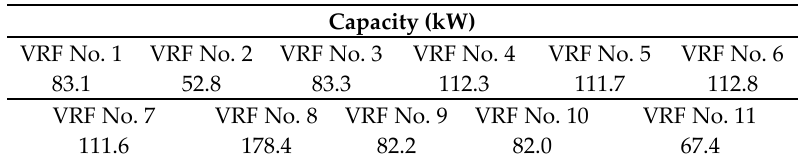
Table 4. Baseline of internal heat gain.